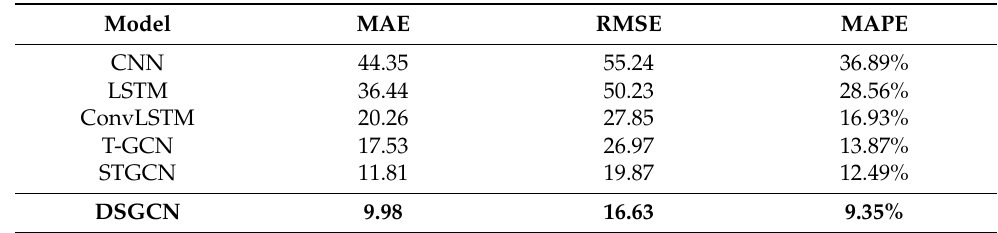
Table 1. Results of the evaluation of the DSGCN model and other baseline method models in the dataset at 15 min.